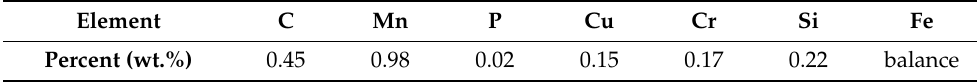
Table 1. Chemical composition of the experimental low carbon steel.